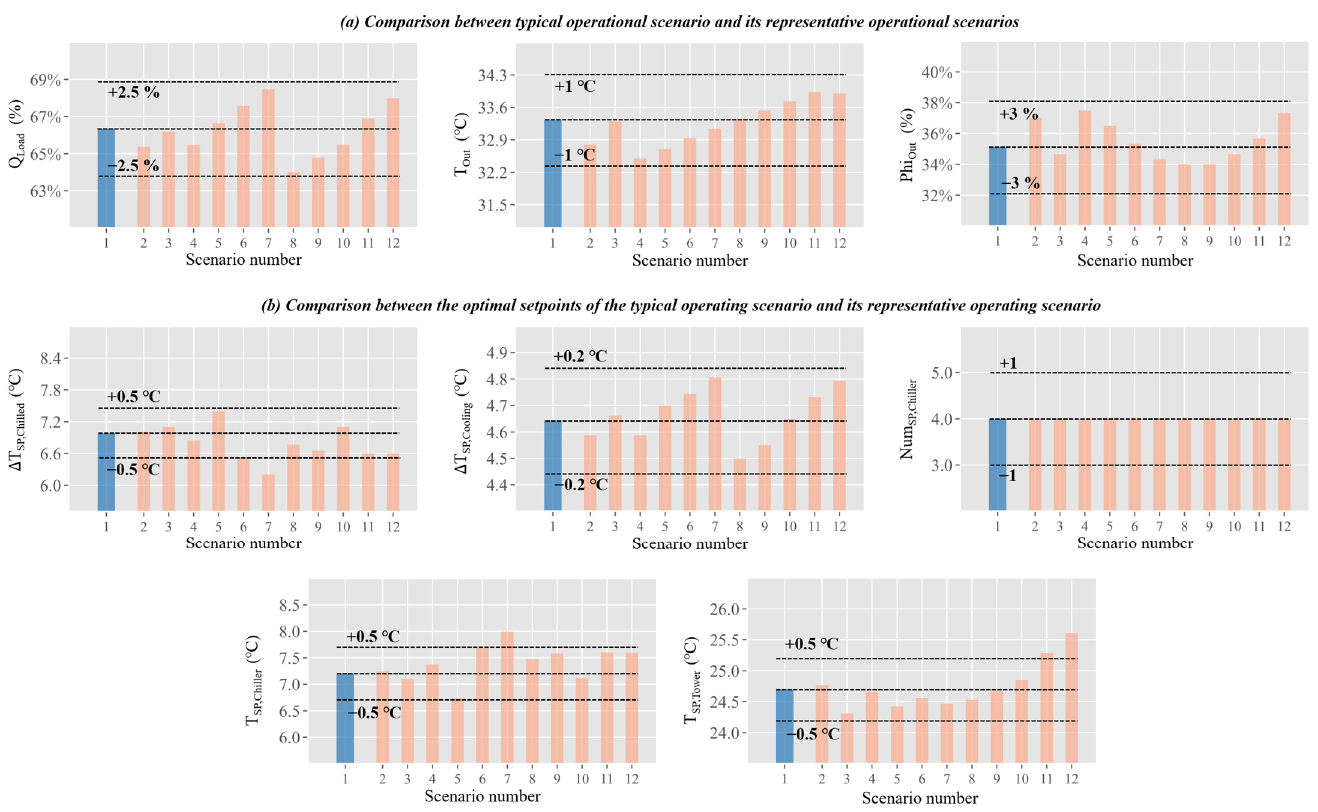
Figure 12. Analysis of optimal setpoints for typical and corresponding similar scenarios (blue bars represent typical operation scenarios, and orange bars represent the similar scenarios that the typical ones represent).